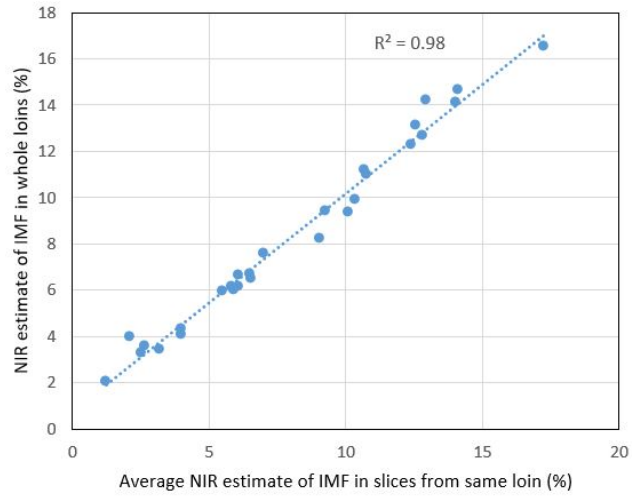
Figure 5. Relation between NIR fat estimates for intact loins and average fat estimates for the loin slices.